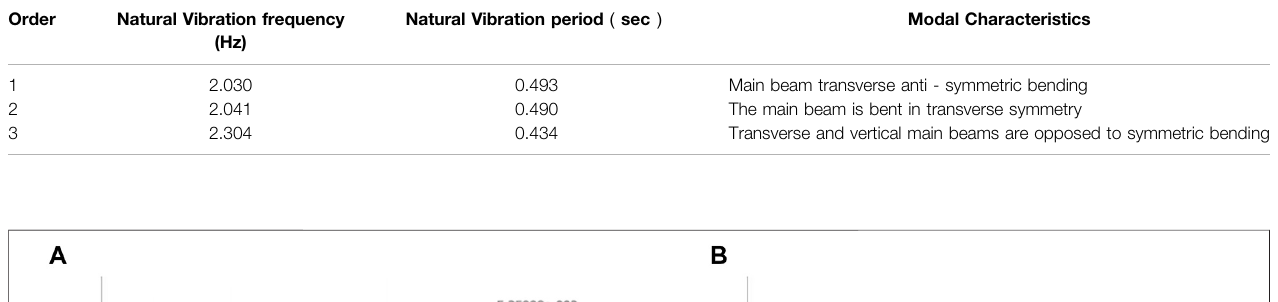
TABLE 2 | The fi rst 10 natural vibration frequencies and periods.